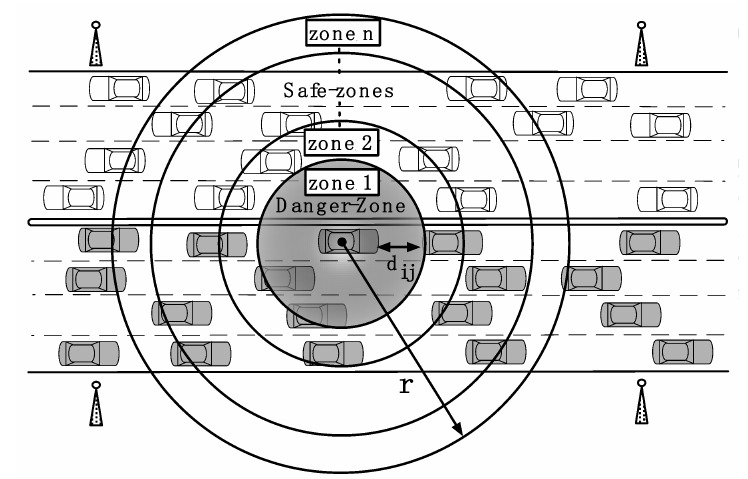
Figure 4. Close proximity concept. The first area is the danger-zone which has the highest priority for message verification. Other areas are safe-zones where messages are verified based on resource